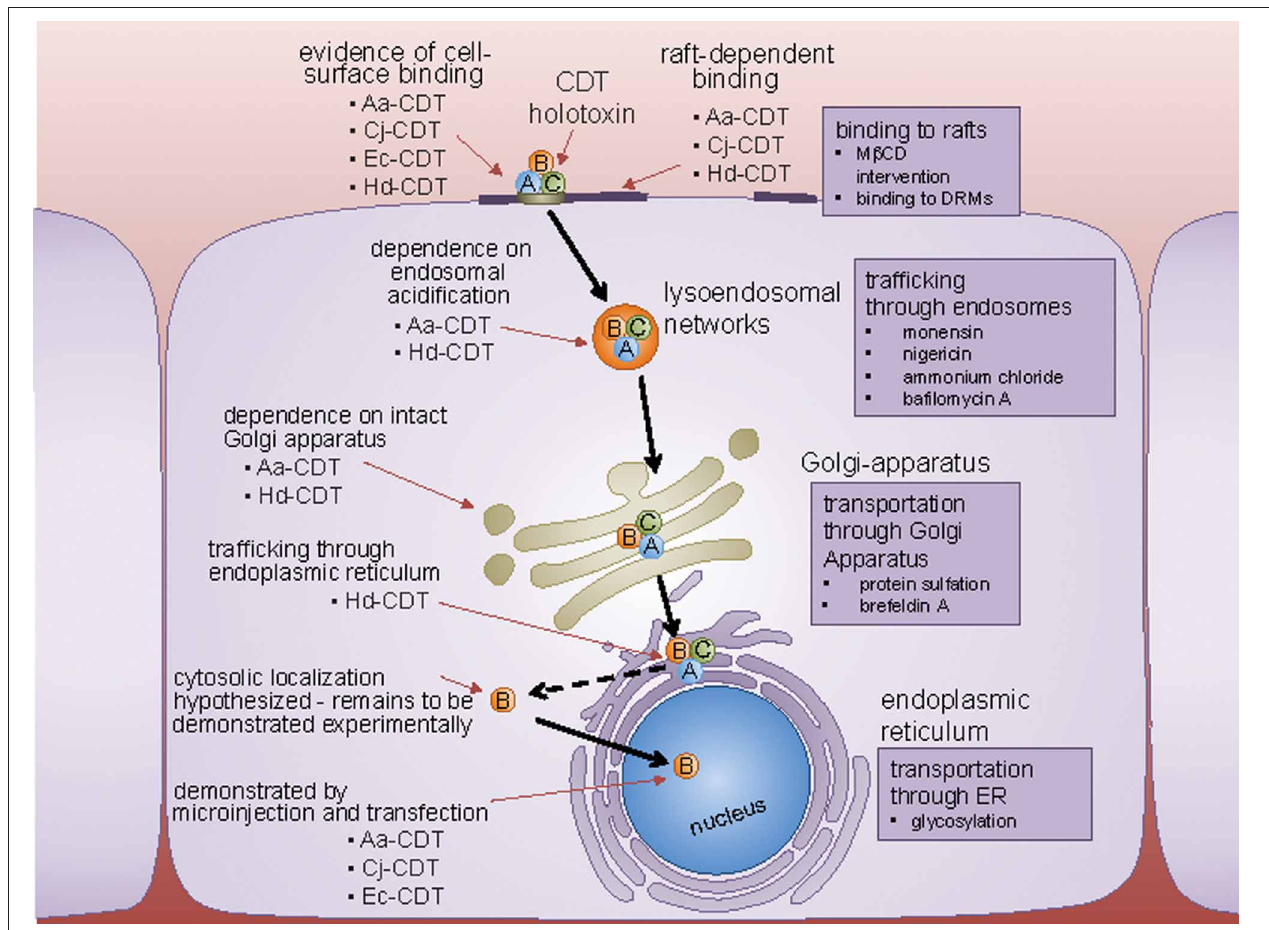
FIGURE 3 | Host cell surface binding and internalizationof CDT. CDT binds to a cell surface determinant, and in some cases, is affected by perturbations in lipid rafts. Following internalization by clathrin-coated pits to the endosomes, CDT is trafficked in a retrograde fashion to the Golgi-apparatus,